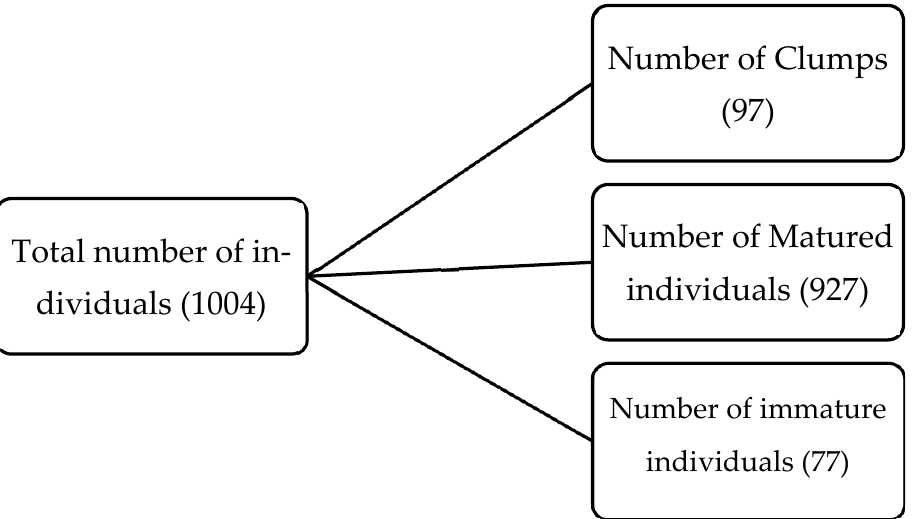
Figure 2. Total Paphiopedilum fairrieanum individuals, number of clumps, matured individuals and immature individuals.